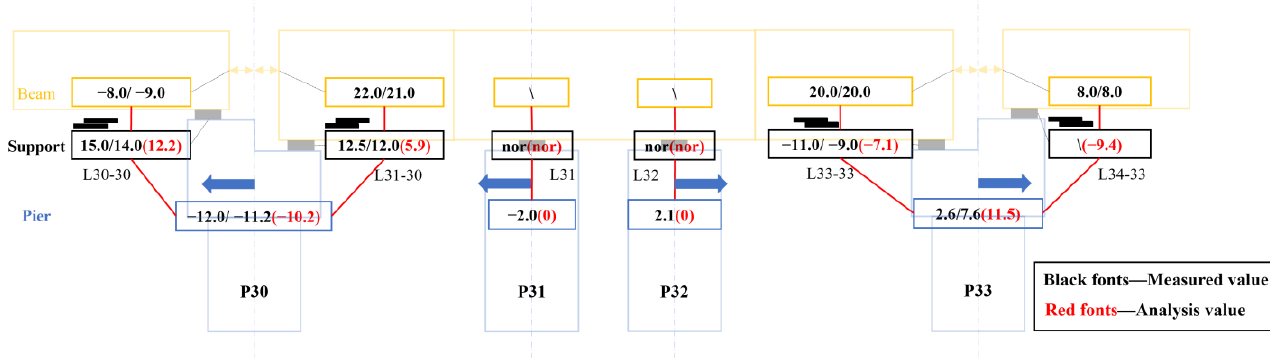
Figure 24. Numerical results and field investigation data between Piers P30 and P33 (cm).